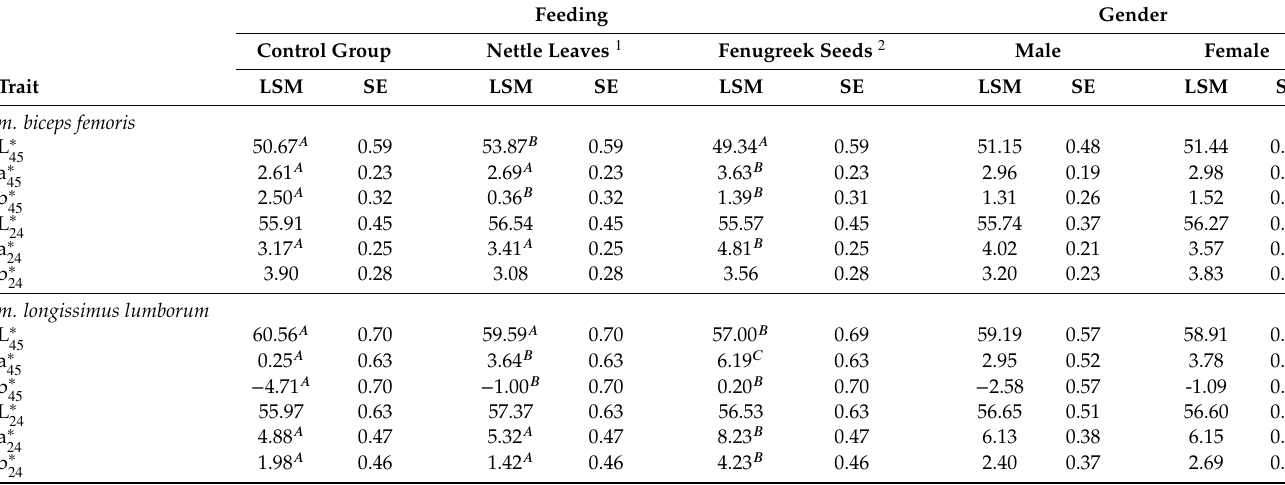
Table 3. Least square means (LSM) with standard errors (SE) of lightness (L ∗ ), redness (a ∗ ) and yellowness (b ∗ ) of meat, by feeding and gender. Feeding Gender Nettle Leaves 1 Fenugreek Seeds 2